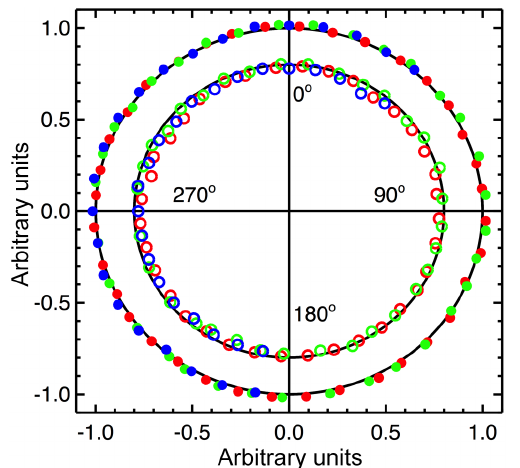
Figure 4. Angle dependence of the instrument line shape (ILS) modulation efficiency at maximum OPD. MCT detector: open cir- cles. InSb detector: filled circles. Green, red and blue measured at an elevation angle of 5, 45 and 65 ◦ , respectively. The black unit cir- cles represent an ideal ILS modulation efficiency having a value of 1.000. See text for details.